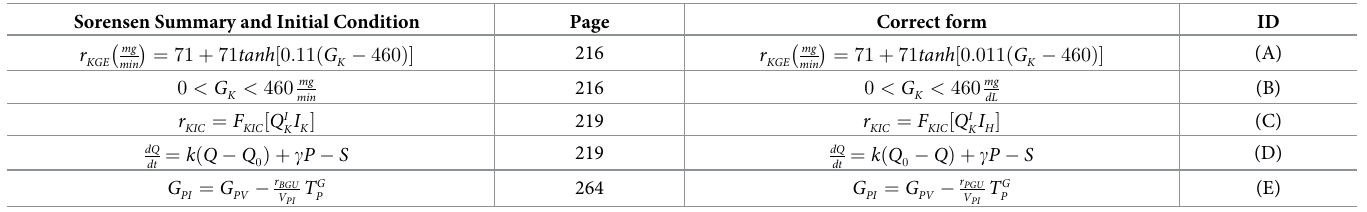
Table 1. Sorensen imprecisions and the relative corrections. Sorensen Summary and Initial Condition Page Correct